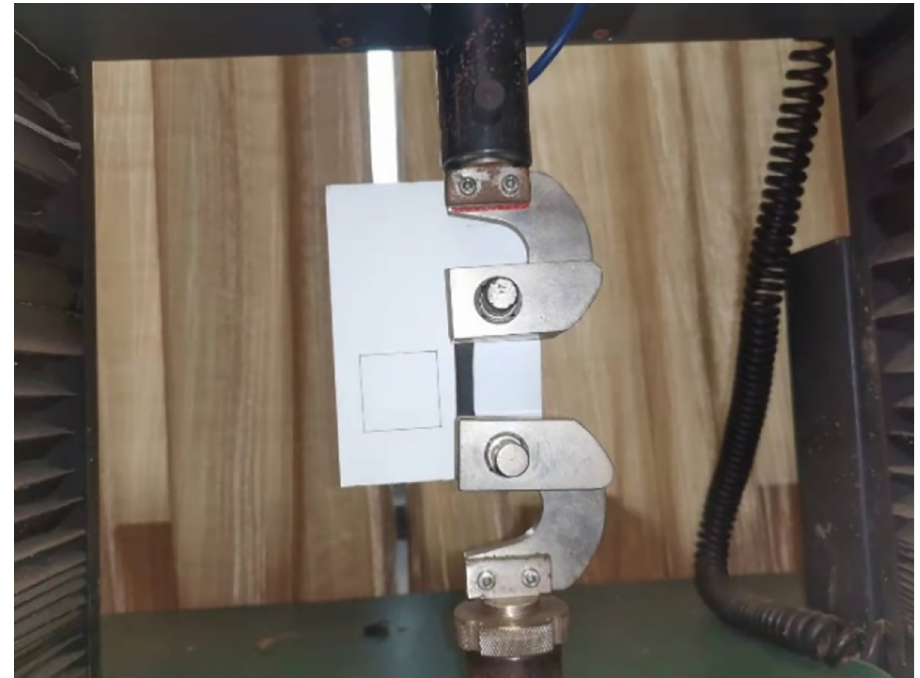
Fig 6. Tensile test of a black fungus leaf.